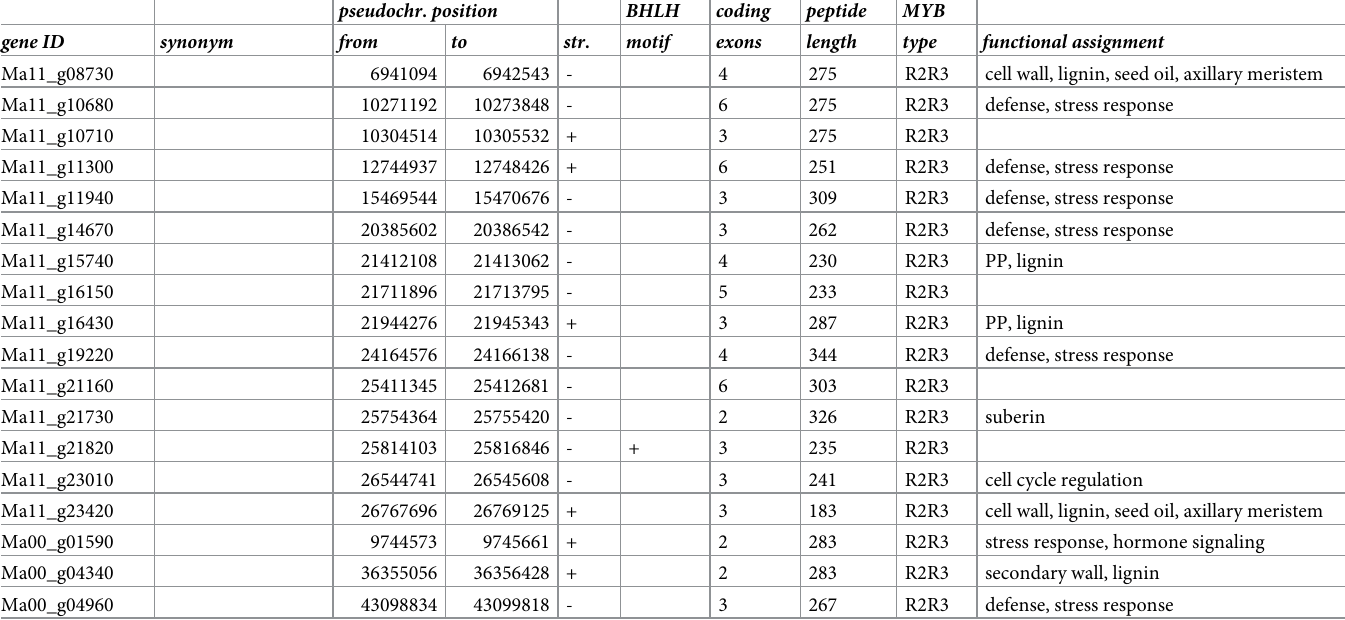
be assigned to the eleven chromosomes. The chromosomal distribution of MaMYB genes on the pseudochromosomes is shown in Fig 1 and revealed that M . acuminata MYB genes are dis- tributed across all chromosomes.